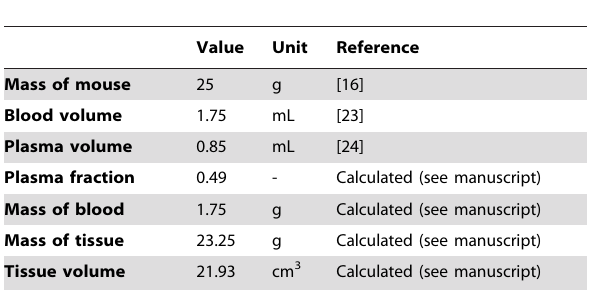
Table 1. Whole-body mouse parameters